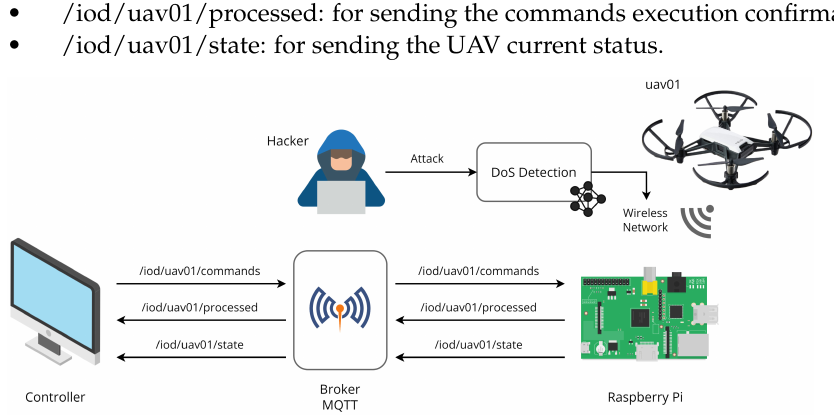
Figure 3. Platform